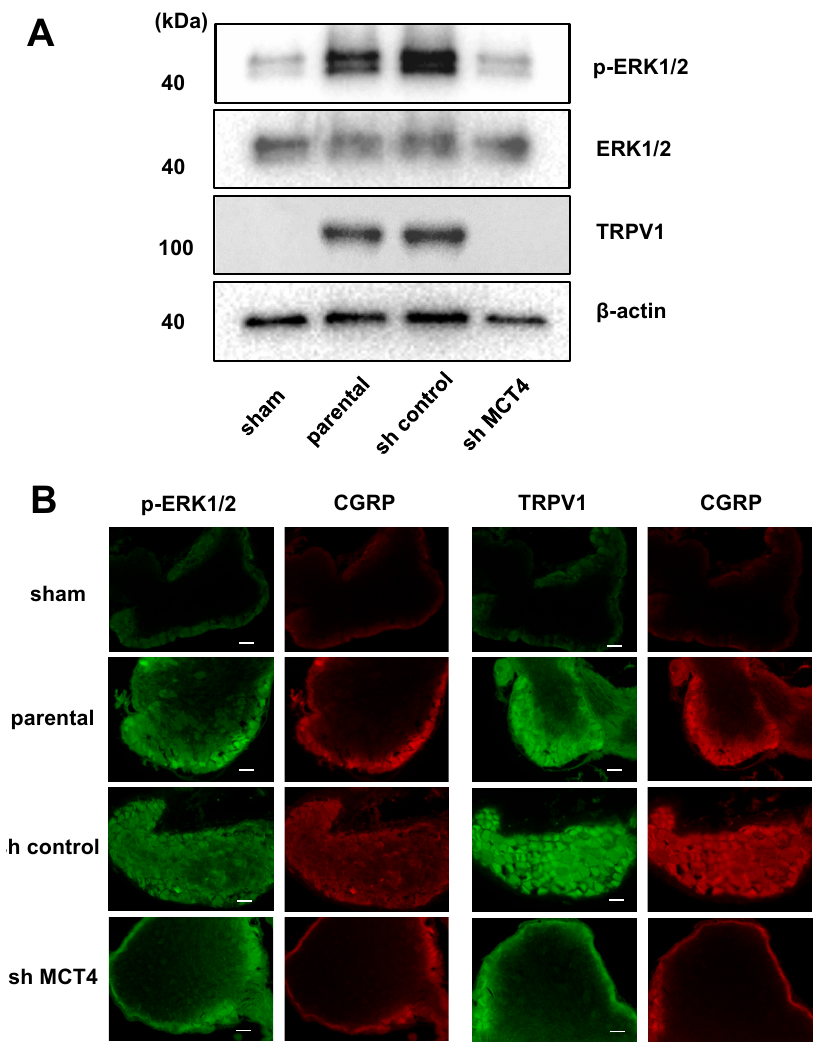
Figure 6. Excitation of sensory nerves determined by p-ERK expression in DRGs in sham, parental, sh-control, and sh-MCT4-injected mice shown by TRPV1 expression. ( A ) Western blotting results. ( B ) Immunofluorescence analysis of p-ERK and TRPV1. ( left ) p-ERK or TRPV1 (green); ( right ) CGRP (red). Scale Bar = 50 µ m. Sections were processed as described in the Materials and Methods section.